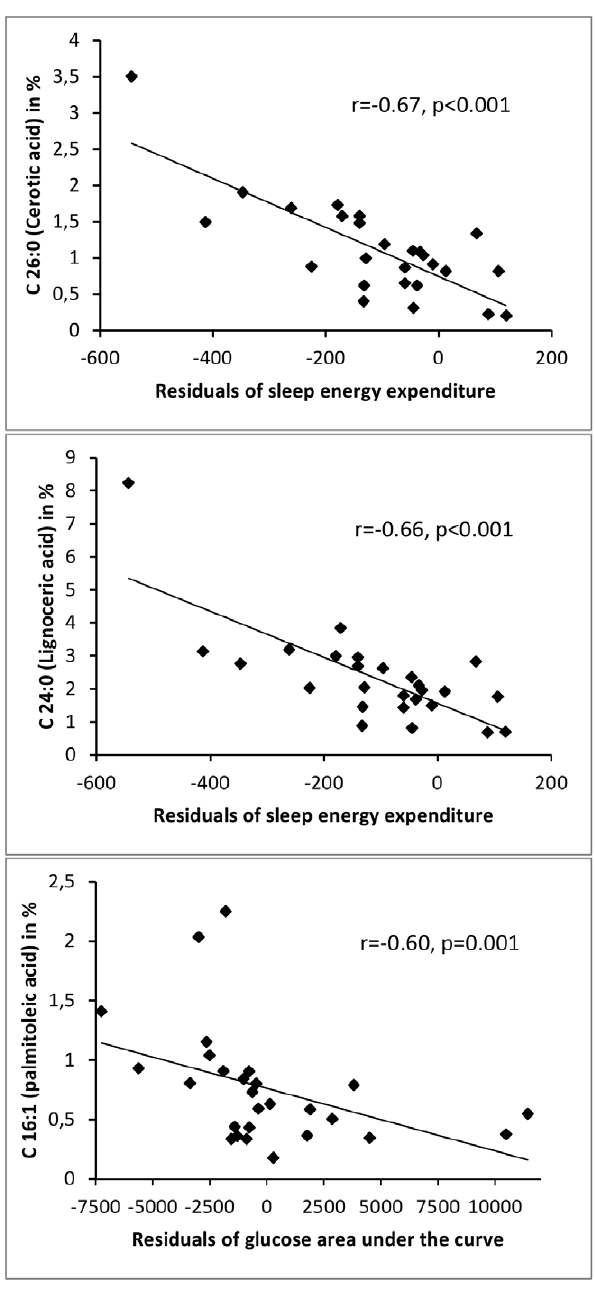
Figure 3. Scatter plots of fatty acids in CSF and metabolic factors. Erucic acid (C26:0, panel a.) and Lignoceric acid (C24:0, panel b.) are negatively associated with residuals of energy expenditure during sleep (SLEEP). SLEEP was adjusted for known confounders as described in the Statistical analyses section of the Materials and methods. Panel c. shows the association of palmitoleic acid (C16:1) with residuals of glucose area under the curve (GAUC). GAUC was adjusted for age, sex and percent body fat. Bonferroni-corrected p-values were a) 0.004, b) 0.004 and c) 0.02. doi:10.1371/journal.pone.0041503.g003 Figure 4. Glucose and insulin levels during the OGTT. Glucose